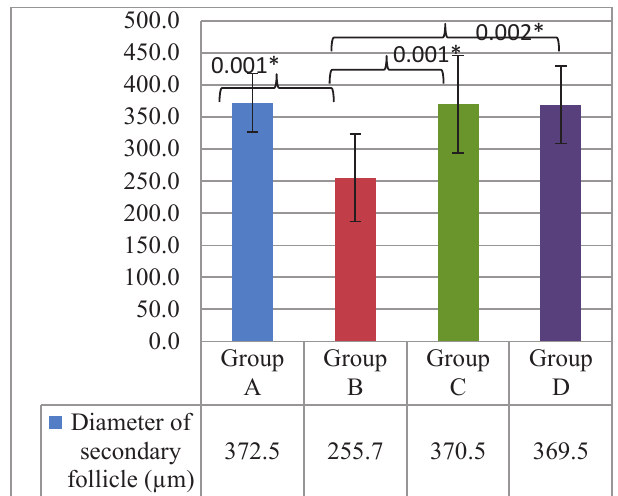
Fig-3: Bar chart showing comparison of diameters of secondary follicles (μm) among different groups.